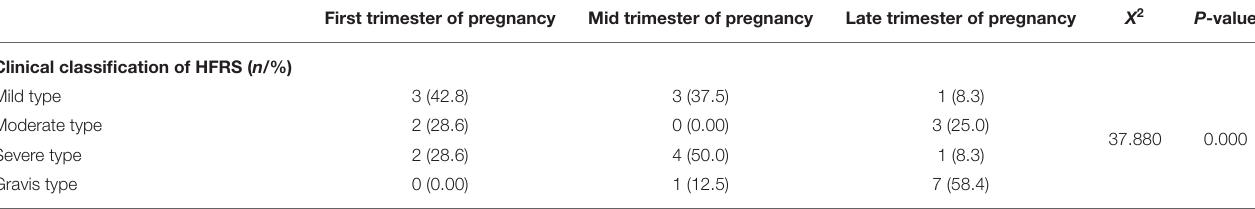
TABLE 2 | Relationship between duration of pregnancy and severity of